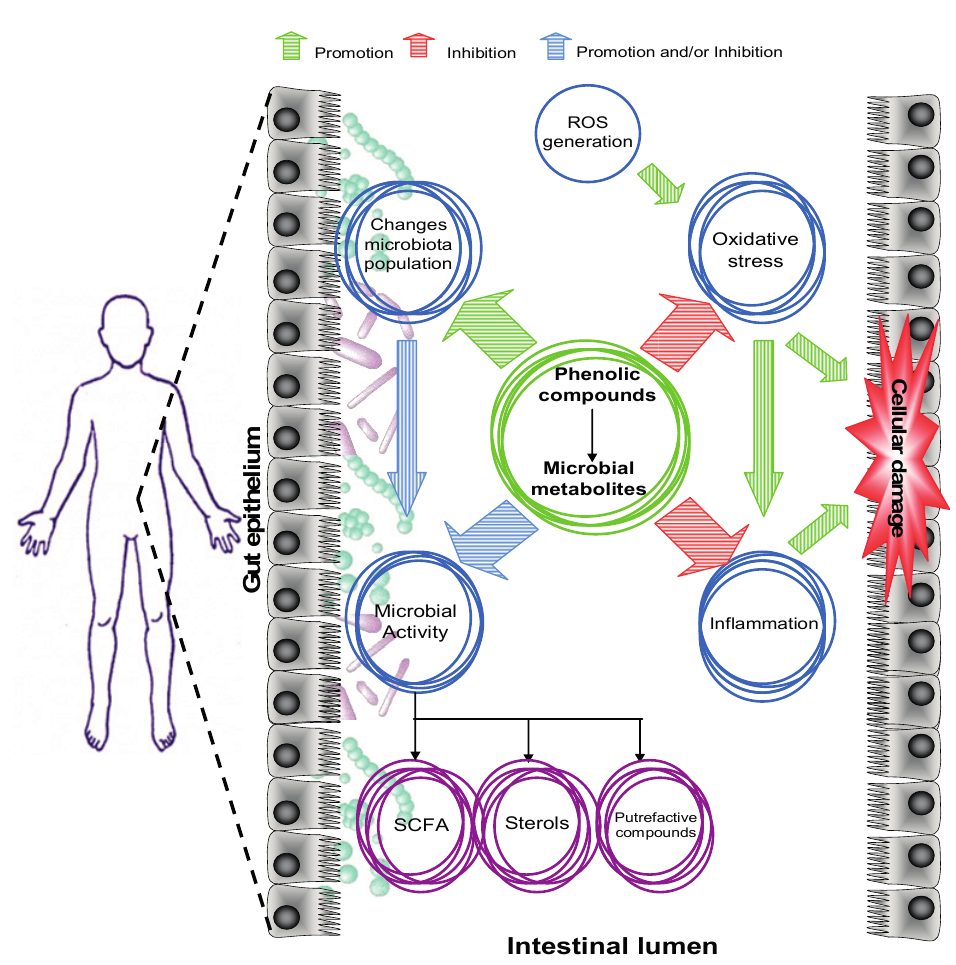
Figure 1. Overview of the possible implications of phenolic compounds at the gut